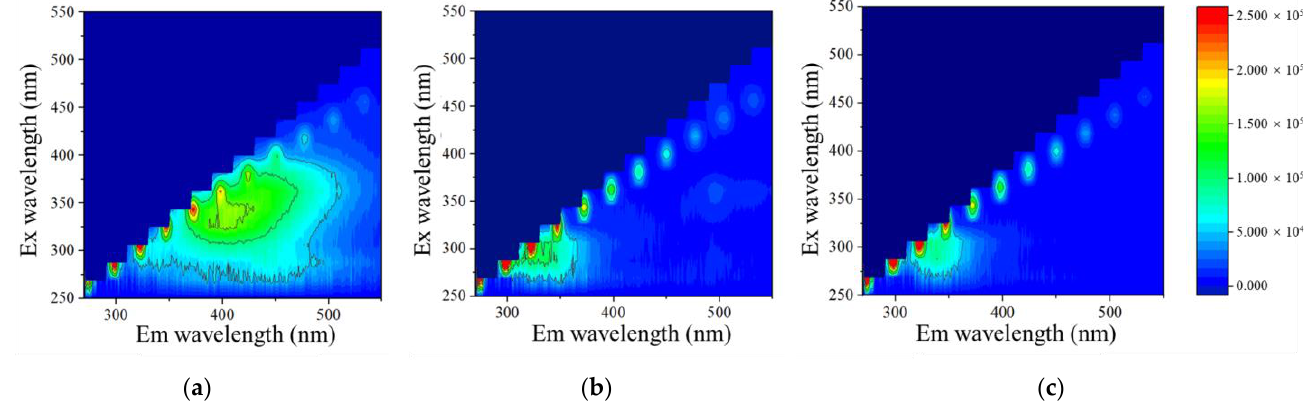
Figure 4. Three-dimensional fluorescence analysis for the ( a ) real shale gas wastewater and perme- ates from the ( b ) PVDF membrane and ( c ) PVDF-CNT-FAS